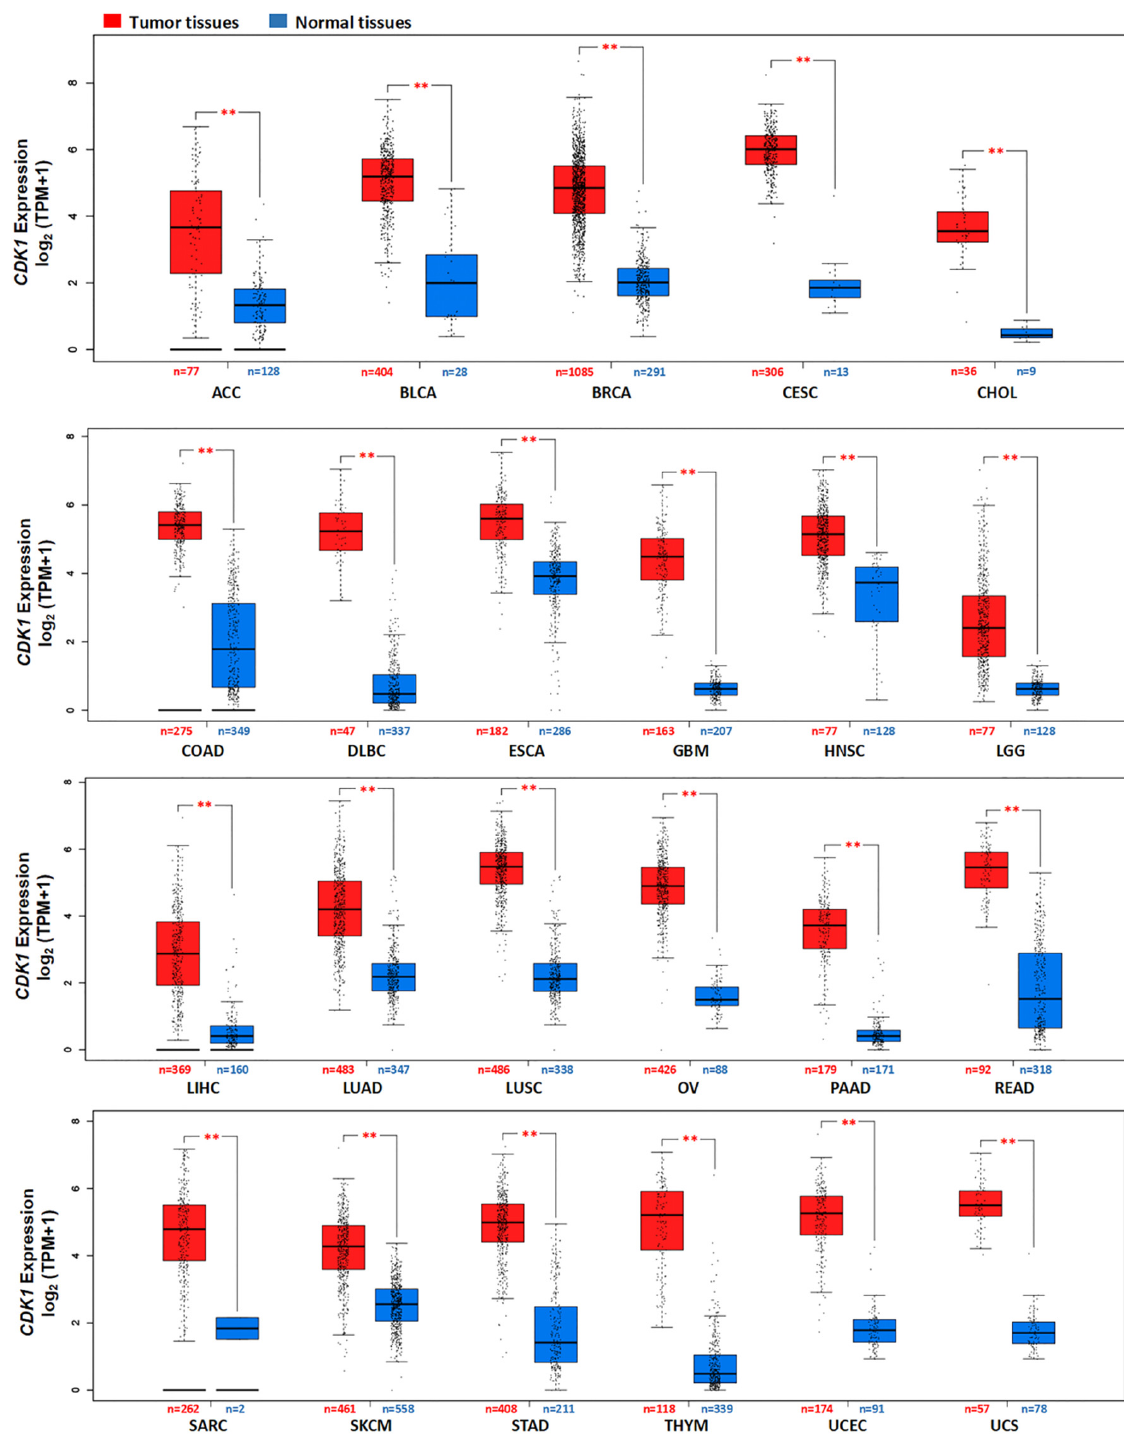
Figure 2. CDK1 mRNA expression in various tumors and normal tissues. The expression of CDK1 in some tumors from the TCGA database was significantly increased as compared to normal tissues from the GTEx database; Expression data were log 2 (TPM + 1) transformed for plotting. ** p < 0.01, Wilcoxon test. TPM: transcripts per million.